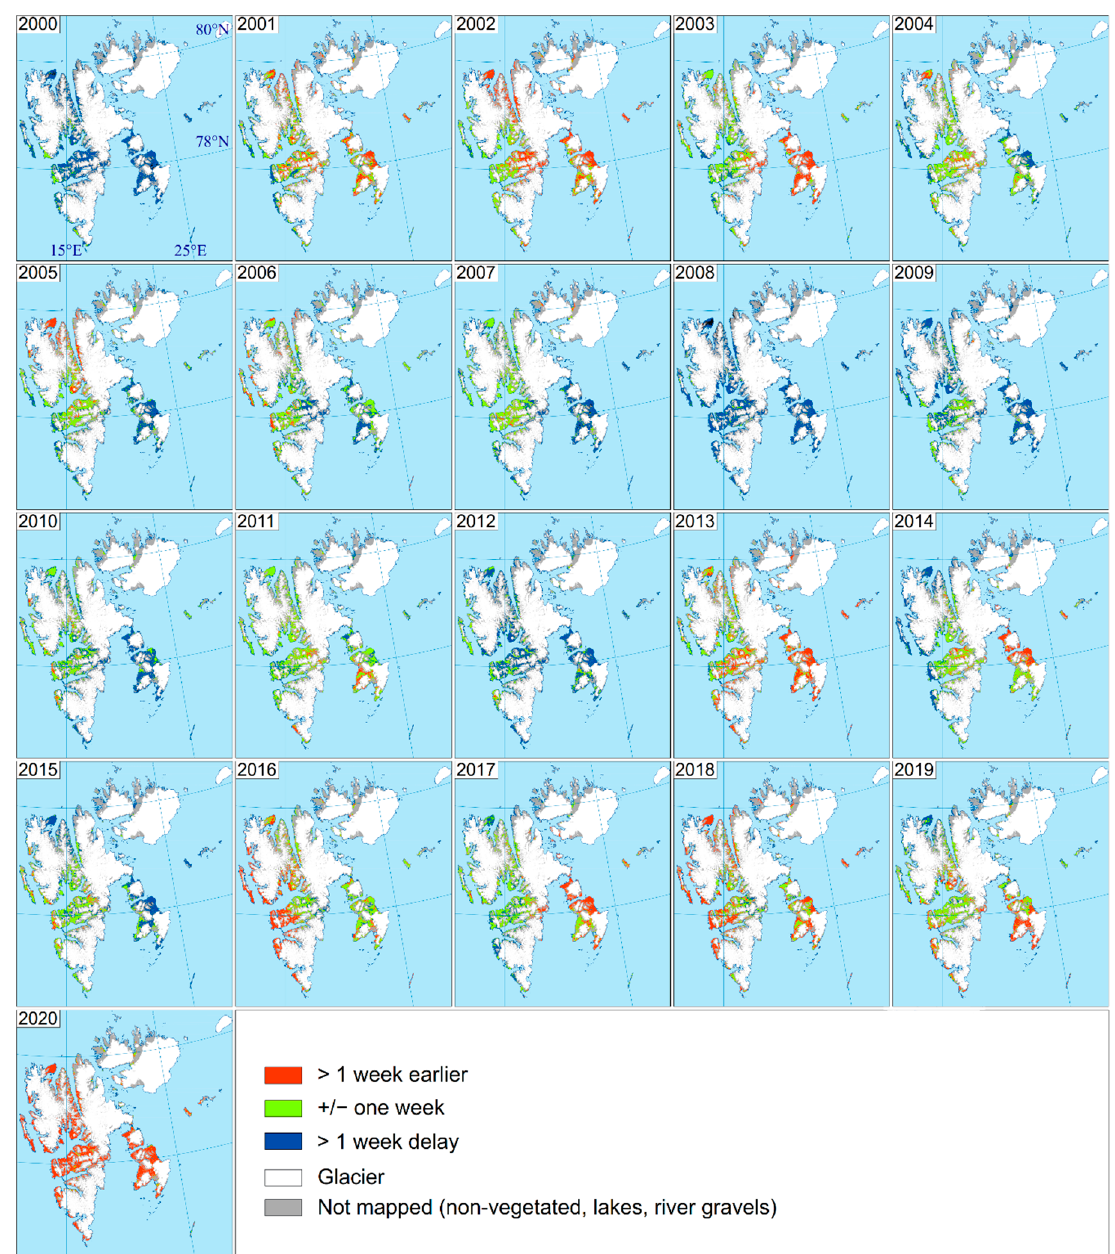
Figure 5. Regional variation in onset of vegetation growth as compared with 2000–2020 mean values.